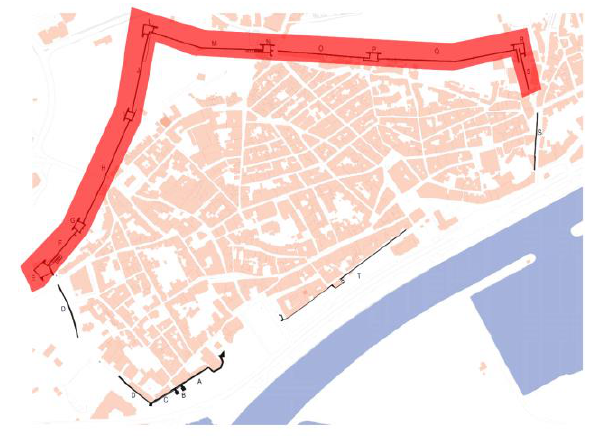
Figure 1. Historic walls of Lagos (the limits of the conservation project are highlighted in